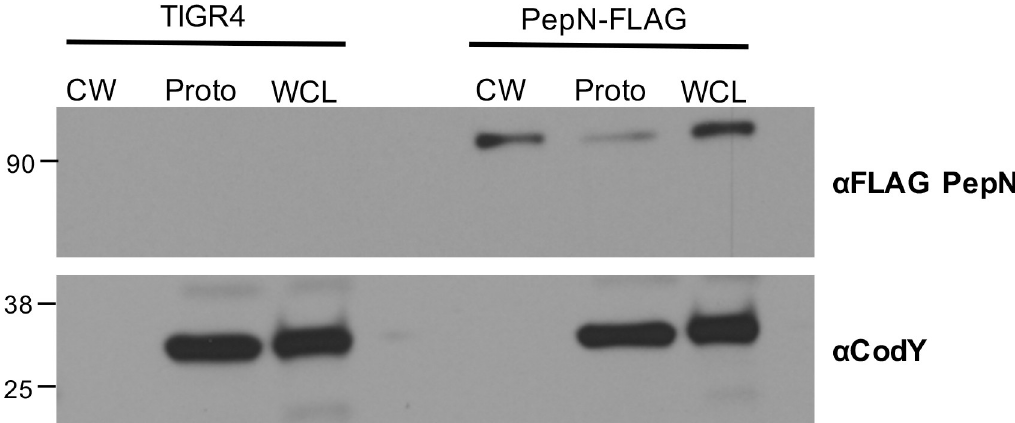
Fig 3. PepN localizes to the cell wall compartment within Spn cells. Whole cell lysates (WCL), CW and protoplast fractions were isolated from OD 600 -matched, mid-log phase TIGR4 and PepNFLAG cells. Samples were analyzed by Western blotting using anti-FLAG or anti-CodY (a cytoplasmic protein) antibodies. Data shown are from one experiment representative of three independent